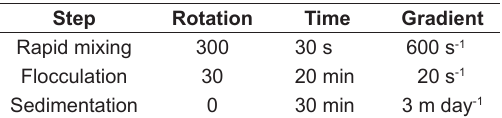
Table 1. Jar test